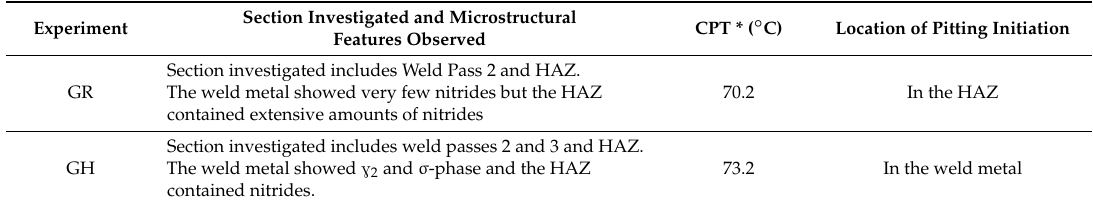
Table 3. Results of ASTM G150 corrosion test, location of pitting initiation and microstructural features.